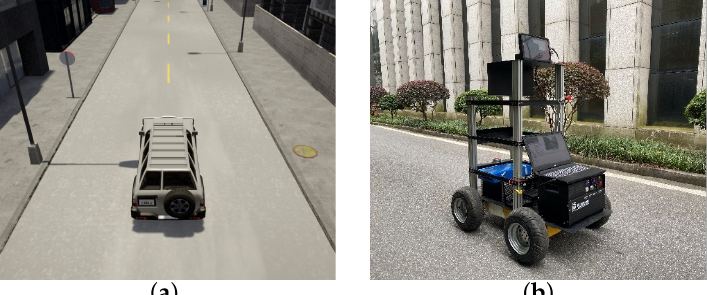
Figure 7. Experiment platform. ( a ) is a virtual vehicle used to collect data in the virtual environment built with CARLA. It was controlled by the DDPG model to learn autonomous driving behavior and equipped with a camera that could provide semantic segmentation images, collision sensors and pose sensors, etc. ( b ) is a small four-wheeled unmanned vehicle used as the experiment platform which could collect the front-view images by a monocular camera and record the vehicle trajectory by the encoder and IMU in the real environment.